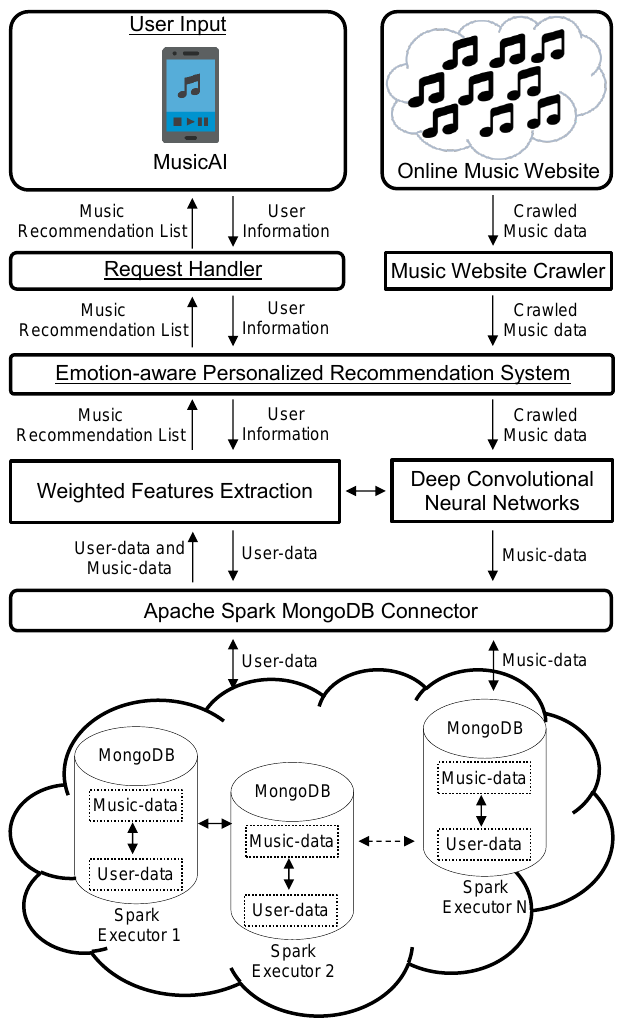
Figure 2. The system architecture and the data flow for the